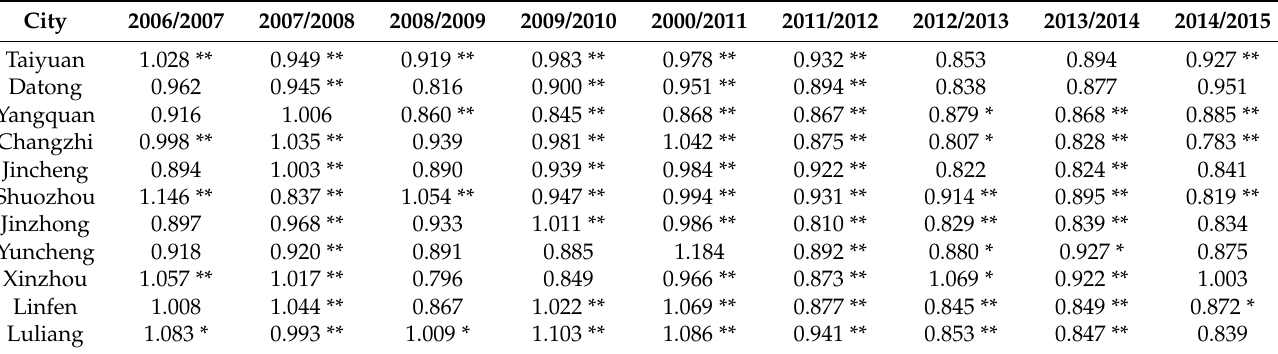
Table 3. The year-on-year land productivity change index for prefectural level cities in Shanxi Province 2006–2015 (Malmquist).